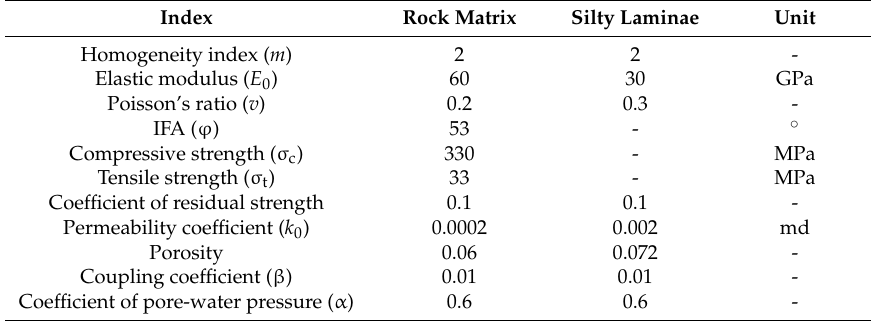
Table 1. Parameters used in multi-parameter optimization. IFA: internal friction angle.